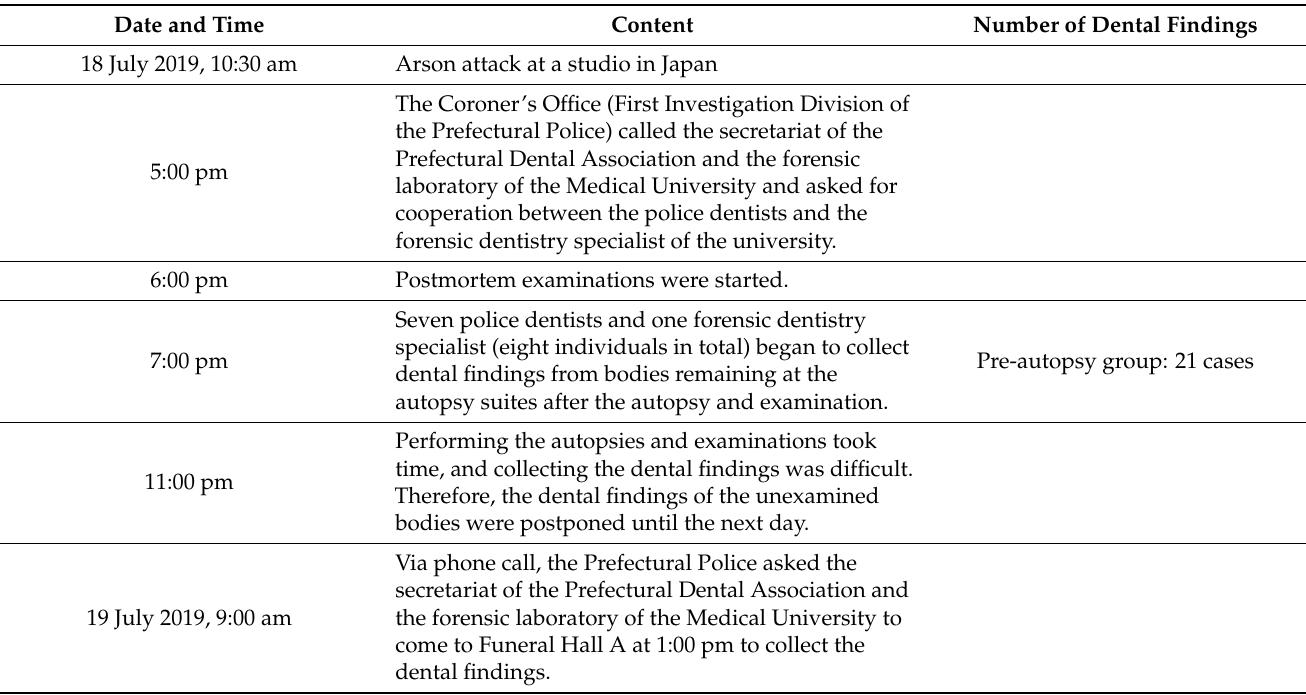
Table 1. The sequential actions of police dentists and forensic dentistry specialists from the incident until the collection of dental